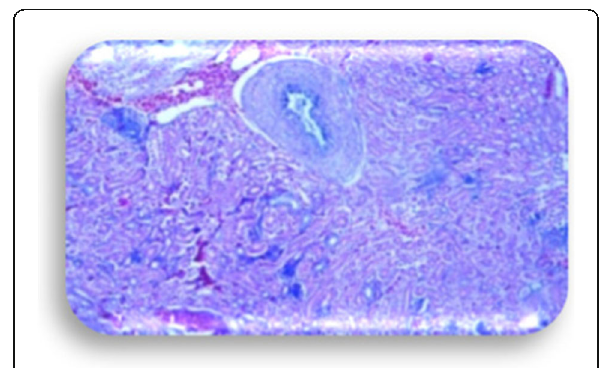
Fig. 8 Vascular and degenerative changes, ×200 For chicken of groups fed 15% prickly pear peels